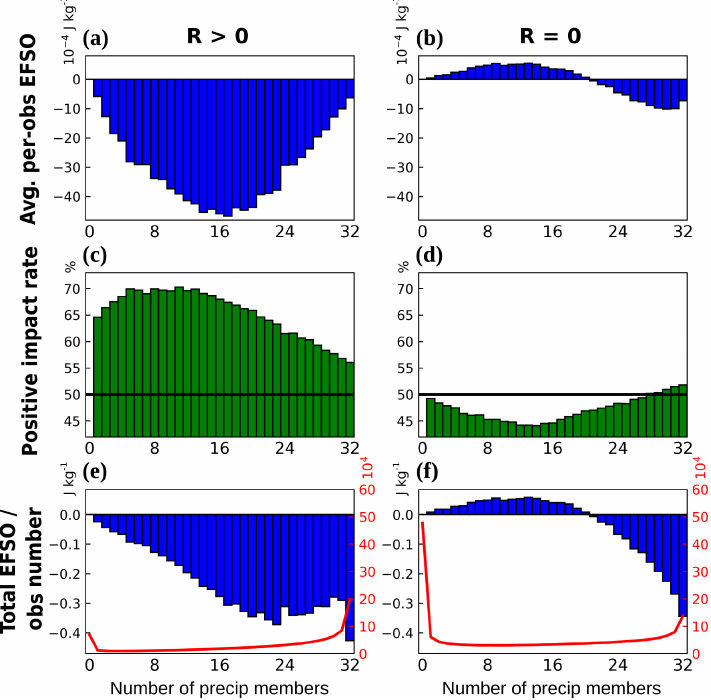
Figure 3. Same as Fig. 2, but for EFSO measured by the moist total energy norm and computed separately for (first column) non-zero precipitation observations ( R >0) and (second column) zero precipitation observations ( R = 0). Table 1. Settings of CONTROL and all TEST (i.e., ALL, 8mR, 16mR, 24mR, 1mR/24mR) experiments. Experiment Observation Data selection criteria: minimum assimilated number of precipitating background members For non-zero For zero Rawinsonde TMPA precip. obs. precip. obs.